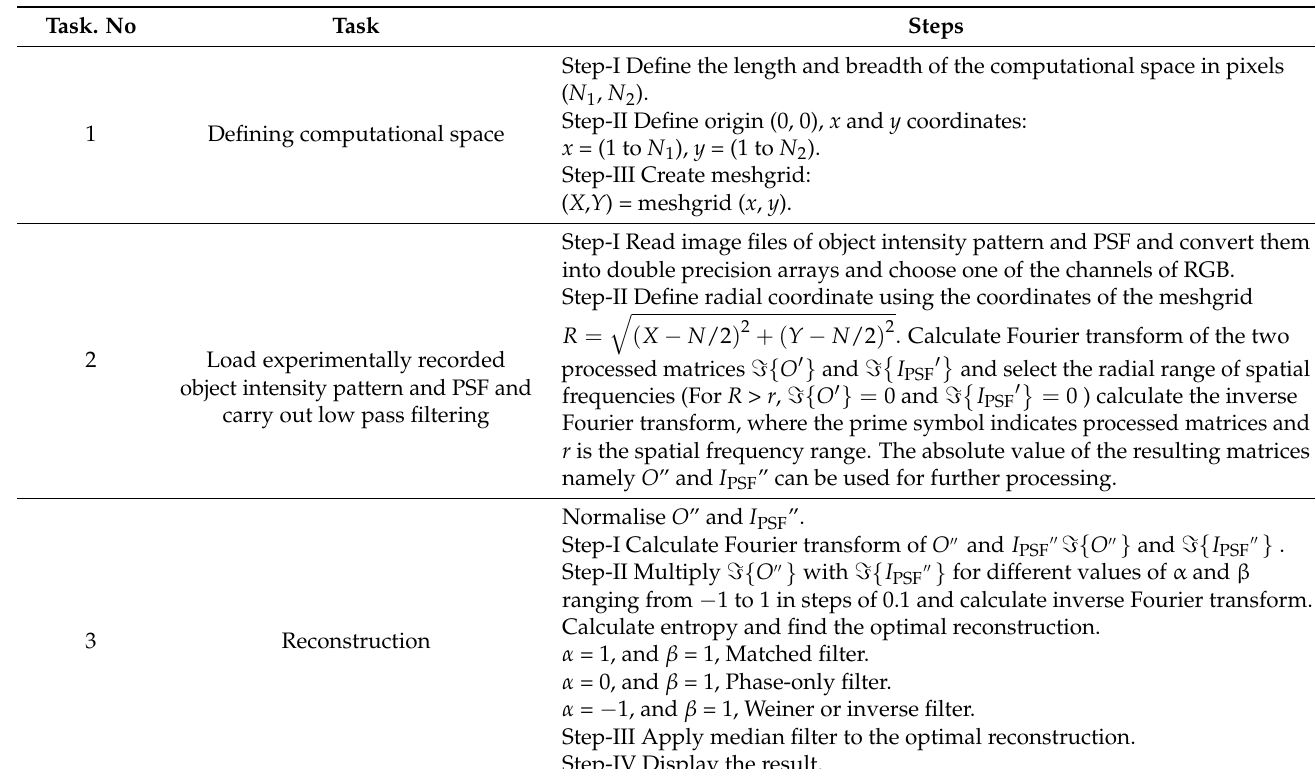
Table 1. Pseudocode for the reconstruction of the image for invasive mode of imaging through occlusion. Task. No Task Steps